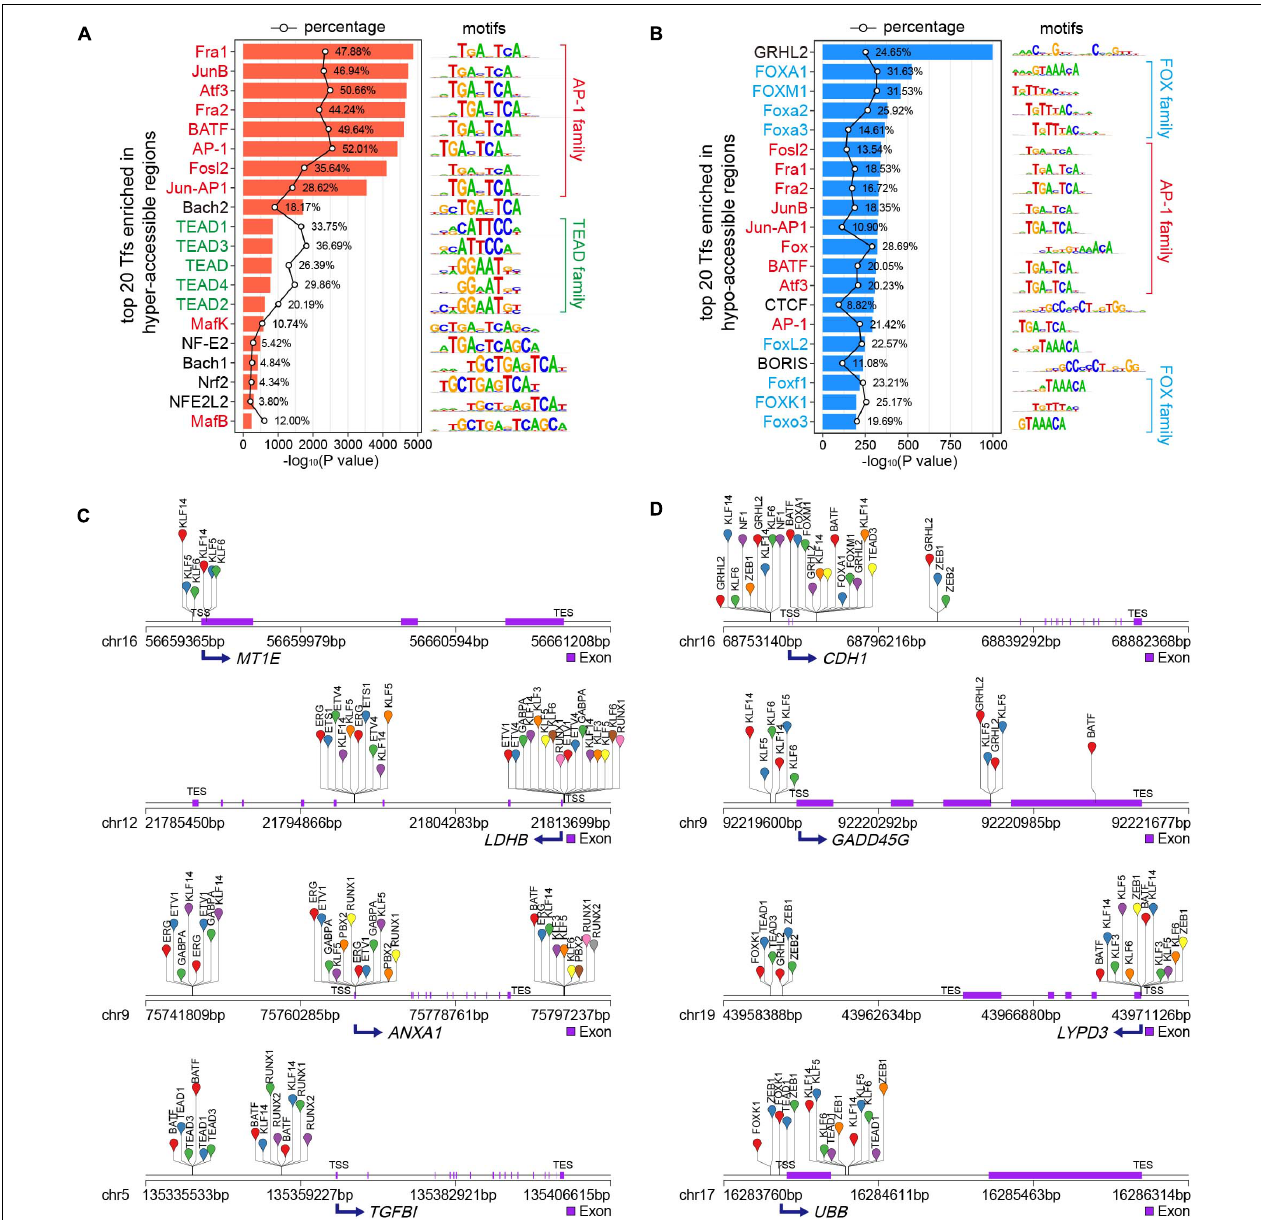
FIGURE 5 | Transcription factor (TF) motif enrichment analysis of DARs. (A,B) Top 20 enriched known TF motifs of hyper- (A) and hypo-accessible (B) sites, with P values estimated from HOMER v4.10. The AP-1, TEAD and FOX family members were colored red, green and blue, respectively. The polygonal chain in black shows the percentages of target sequences with TF motifs. (C,D) Putative TF occupancy of representative up- (C) and down-regulated (D) DEGs positively correlated to chromatin accessibility